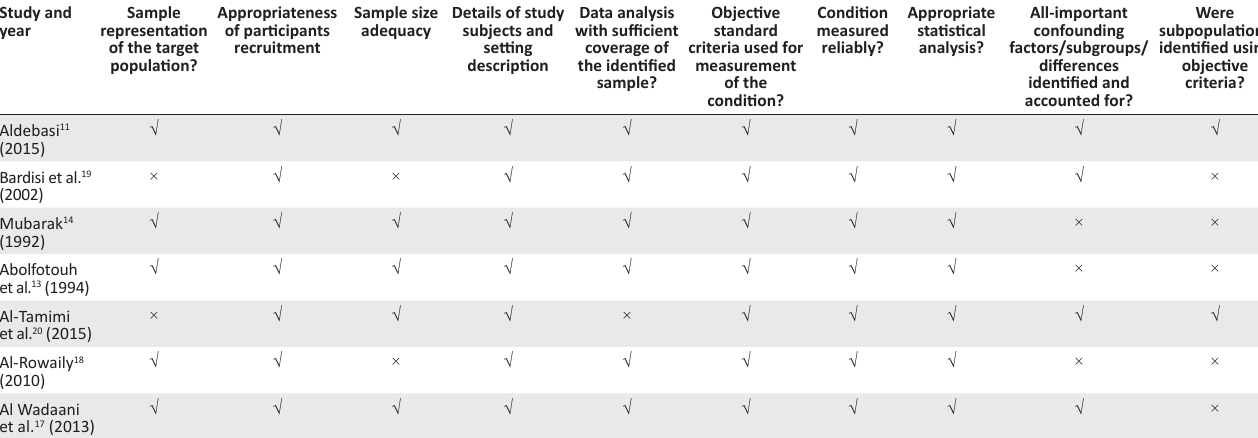
TABLE 1: Quality evaluation of included studies according to Munn’s criteria. Study and